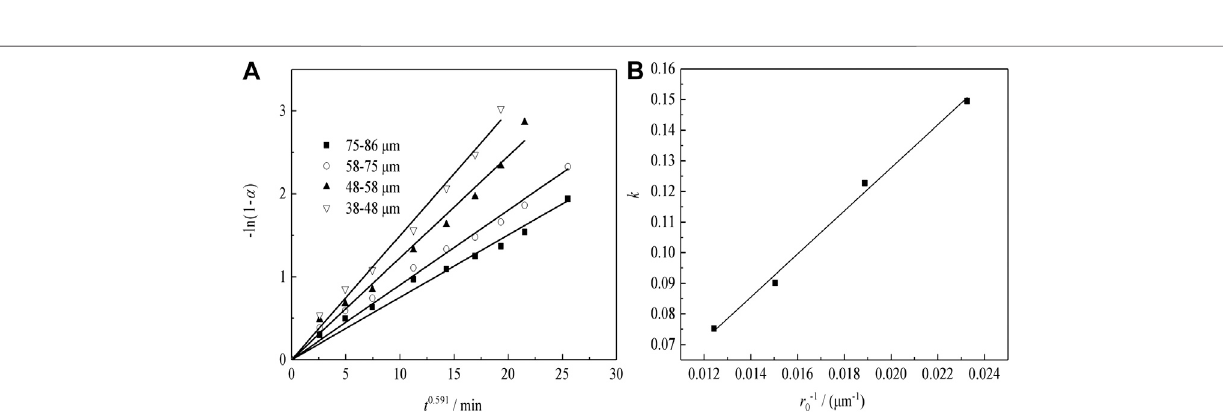
FIGURE 12 | Transformation ratio of Nd and kinetic analysis with various particle sizes.